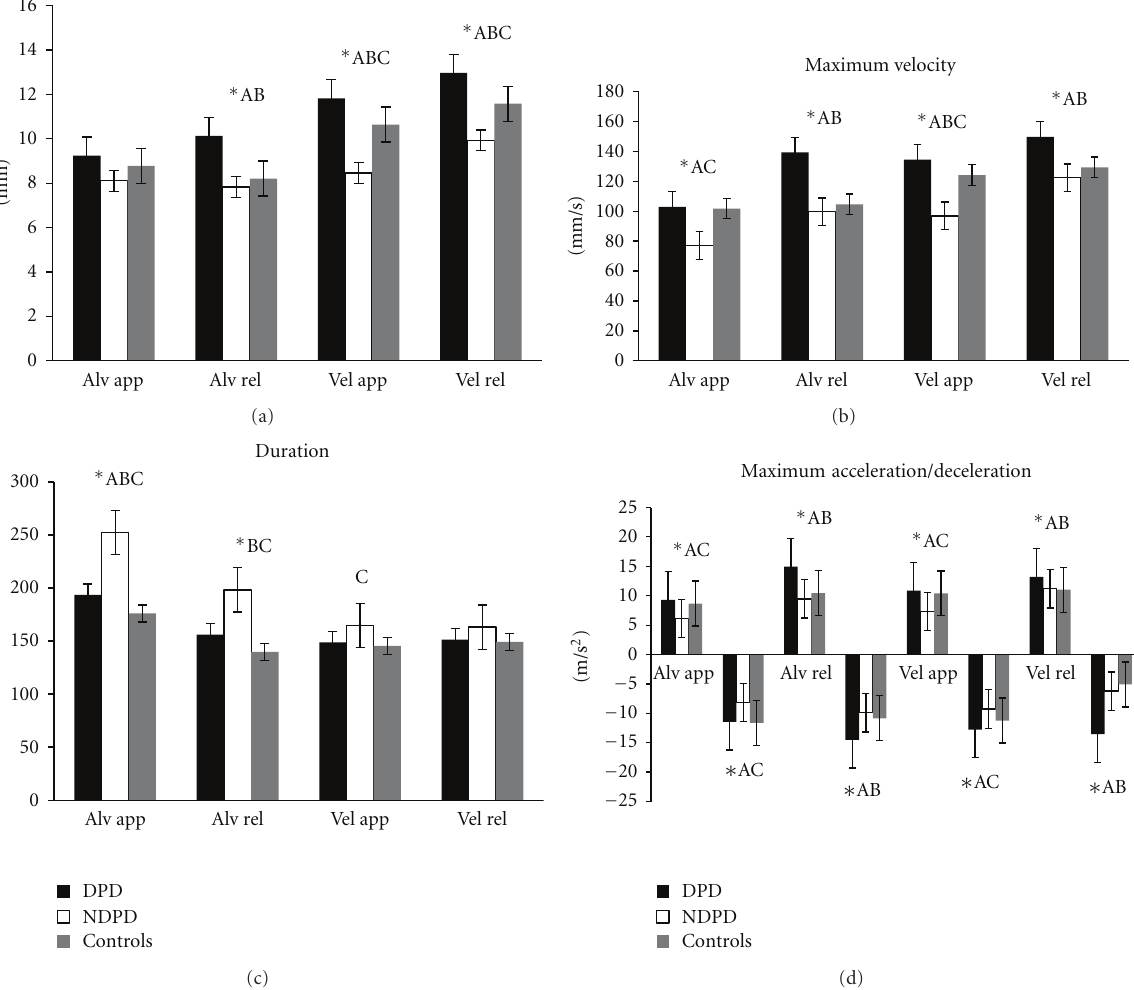
Figure 2: Mean (and standard error) kinematic parameter values recorded for the DPD, NDPD and normal groups. DPD: dysarthric speakers with Parkinson’s disease, NDPD: nondysarthric speakers with Parkinson’s disease, Alv: alveolar sentence, Vel: velar sentence, app: approach phase, and rel: release phase, Significant di ff erences between group comparison: ∗ = DPD versus NDPD versus controls, A: DPD versus NDPD, B: DPD versus controls, C: NDPD versus